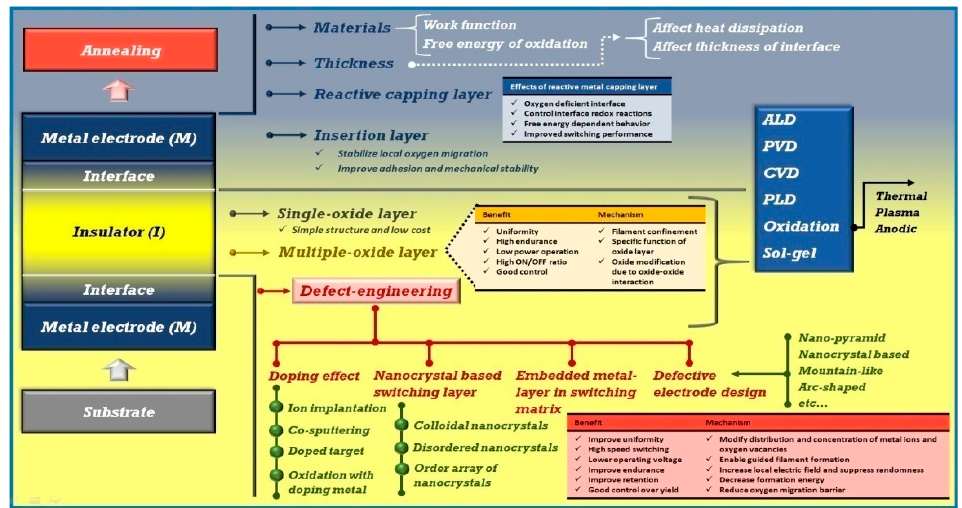
Figure 9. Illustration of material engineering and useful systems to design RRAM devices.